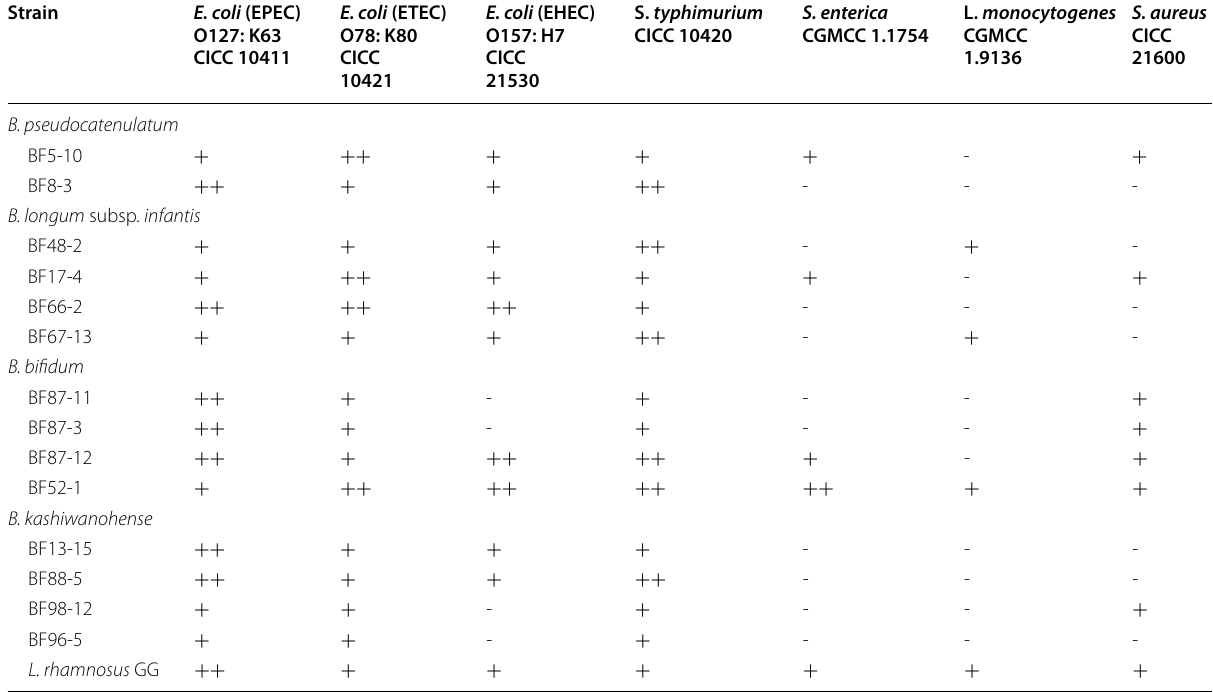
Diameter of the zone of inhibition (including that of the oxford cup of 8 mm): (